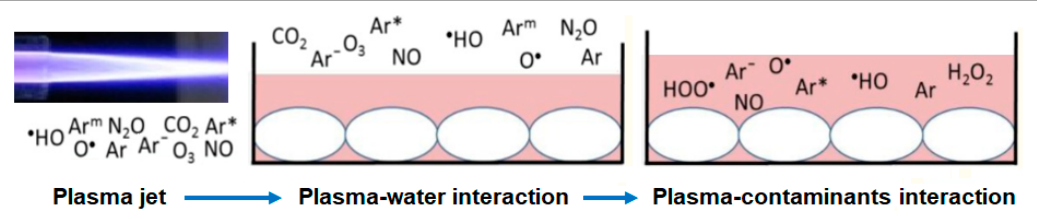
Table 2. Oxidation potential of different chemical oxidizers.